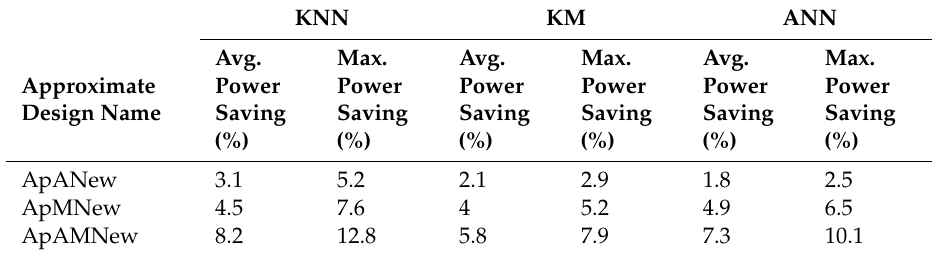
Table 3. Contributions of dynamic sizing to the power saving percentages of the new approximate blocks, given as the average and maximum of the results from di ff erent datasets for each algorithm. KNN KM ANN Approximate